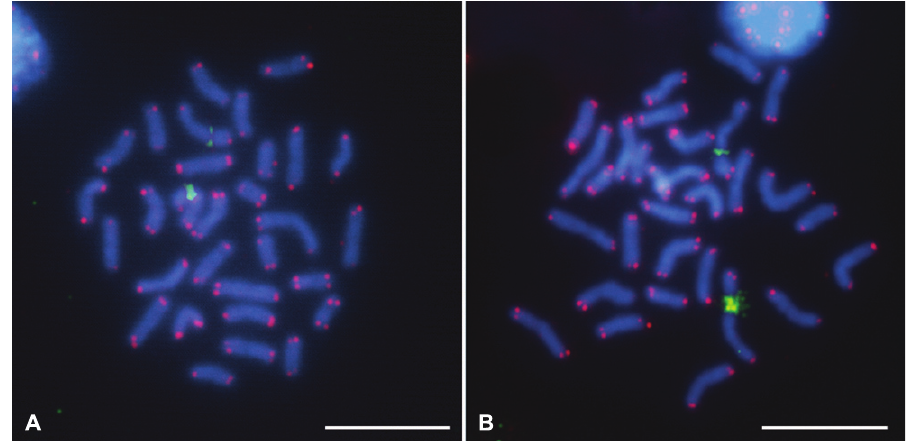
Fig. 2, A, B. FISH in H. magnipapillata mitotic chromosomes with telomere (red signals) and 18S rDNA (green signals) probes. The telomere signals are visible on all chromosomes ends. Two different mitotic plates are shown ( A , B ). Chromosomes are counterstained blue with DAPI. Bars = 10